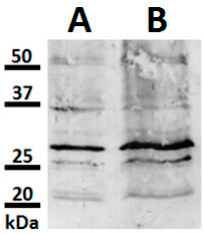
Figure 1. WB of proteins from RGSM revealing candidates for anti-peptide Ab interaction. RGSM proteins from cv. Merlot (15 and 30 µg, A and B respectively) were loaded onto 12% polyacrylamide gel. Western blotting was performed using mouse anti-peptide Ab at the concentration of 5 µg·mL − 1 . Anti-mouse IgM (dilution 1:15,000) was used as secondary antibody. Protein molecular mass markers are shown on the left.